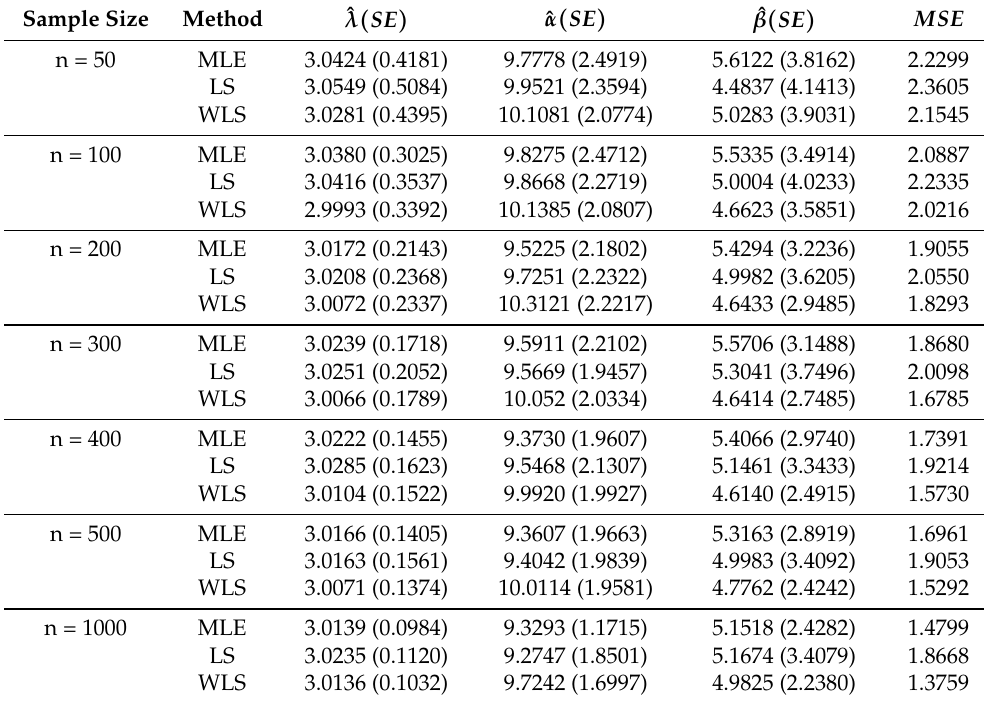
Table 3. λ = 3 , α = 10 , β =